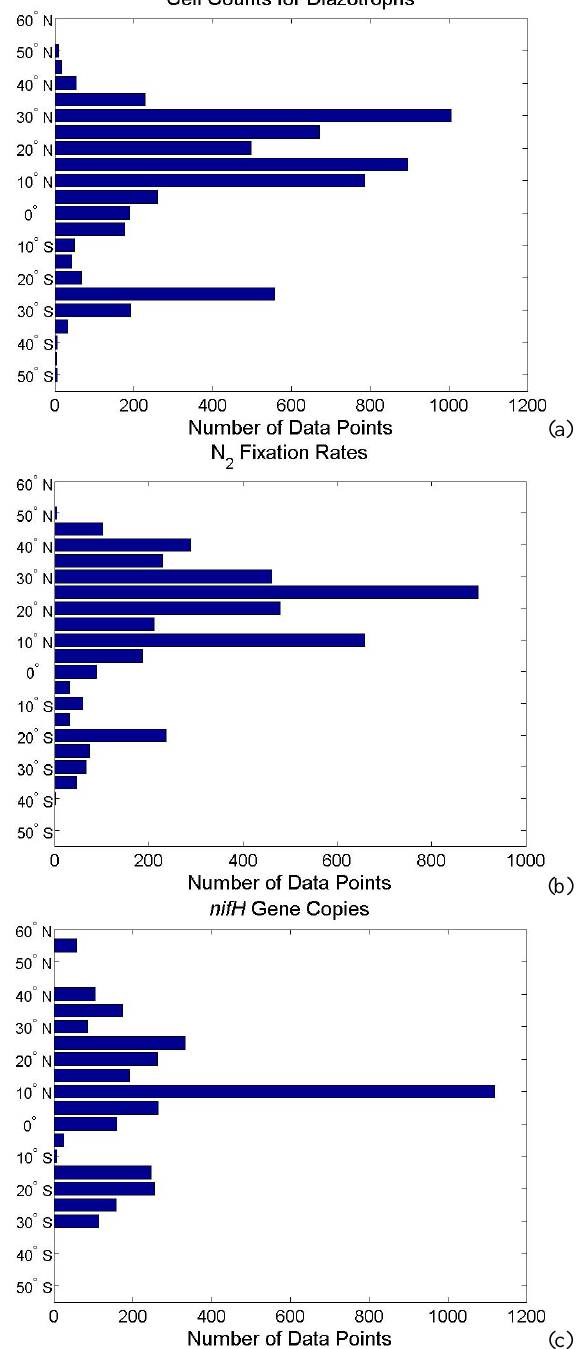
Figure 4. Latitudinal distribution of the data for (a) cell counts for diazotrophs, (b) N 2 fixation rates, and (c) nifH -based